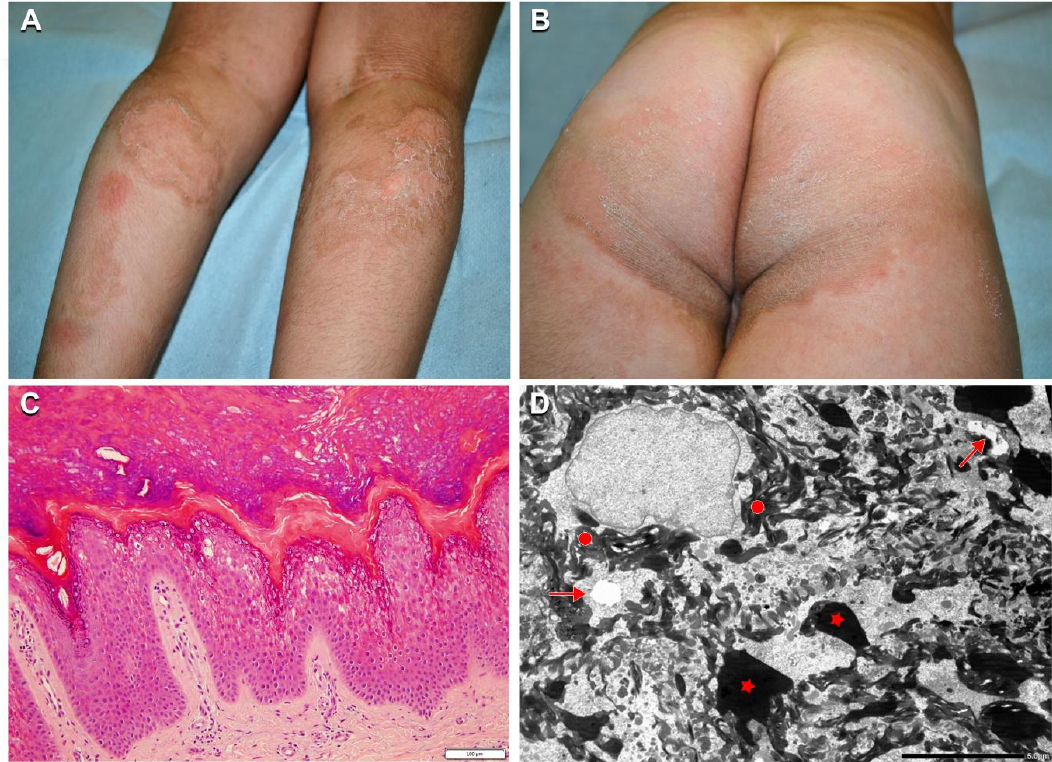
Figure 5. Clinical, histopathological, and ultrastructural findings in superficial epidermolytic ichthyosis (SEI). Brownish hyperkeratosis on the buttocks and infragluteal folds with linear hyperkeratosis on the right popliteal fossa in a 7-year-old boy ( n . 23 of Table 1) ( A,B ). Note the two erythematous patches on the left calf, and polycyclic mildly erythematous and focally eroded areas with peripheral superficial lamellar desquamation on both calves ( A ). Leg hypertrichosis is also evident ( A ). Skin histopathology shows vacuolization of the granular and upper suprabasal epidermal layers, with numerous eosinophilic inclusions ( C ). Ultrastructural examination reveals initial cytoplasmic vacuolization in the granular layer (arrows) with extensive tonofilament clumps (filled circles) and keratohyalin granules of irregular size and shape (asterisks) ( D ). Bar: 100 µm in ( C ) and 5.0 µm in ( D ).